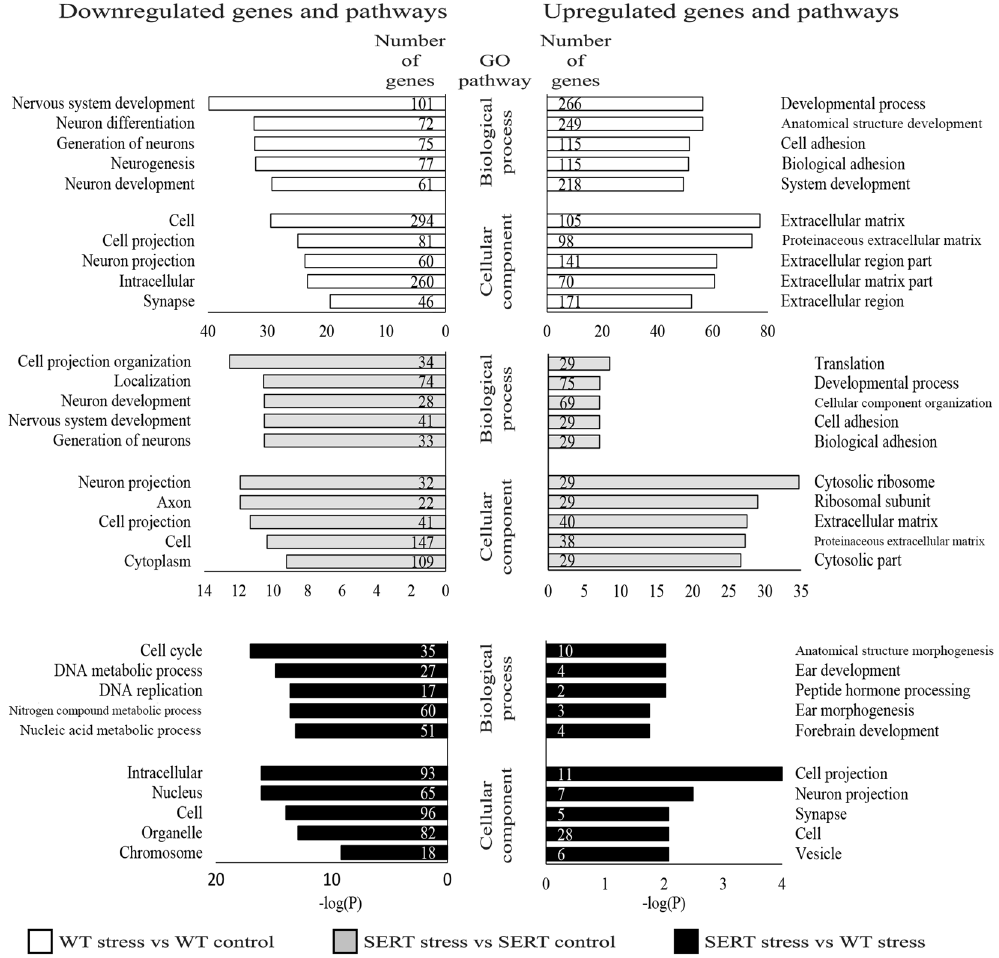
Figure 3. Analysis of gene ontology for biological processes and cellular component for downregulated (left panel) and upregulated (right panel) genes from WT embryos in response to stress (top panel), SERT embryos in response to stress (middle panel), and the gene x environment interaction (bottom panel).